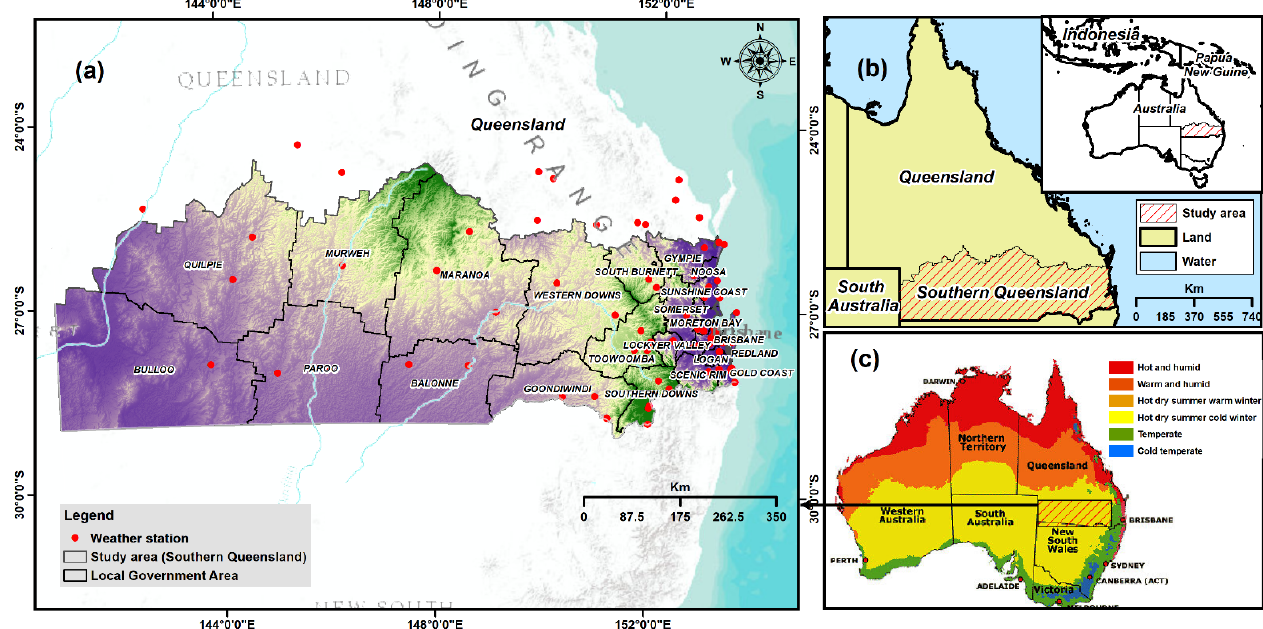
Figure 1. ( a ) Extent of study area outlining weather stations drawn on SRTM elevation data; ( b ) Study area in the context of entire Queensland State and Australia; and ( c ) Climatic zones of Australia .